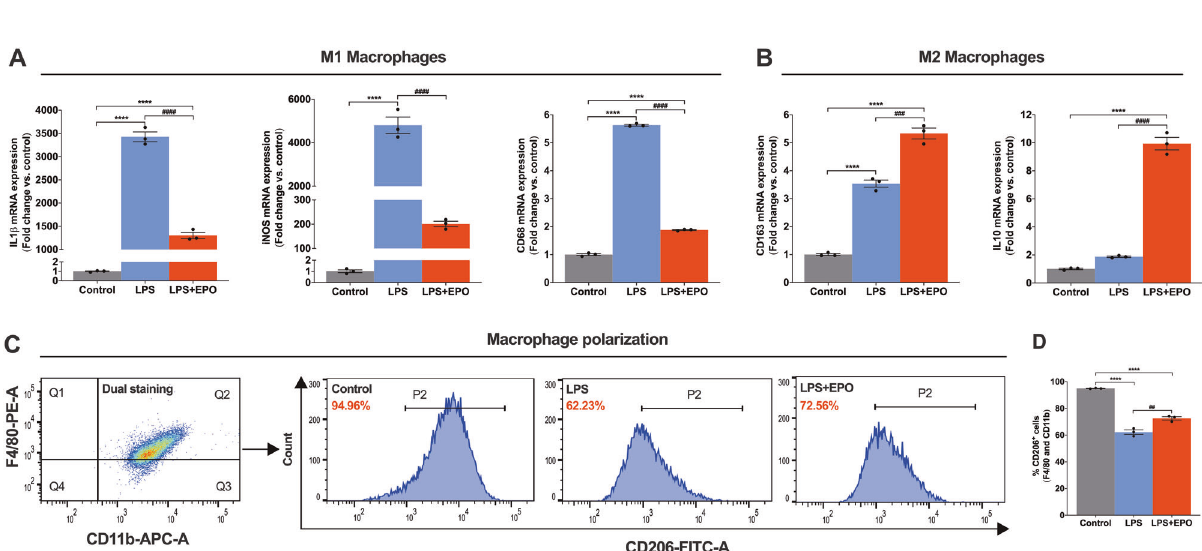
Fig. 5 EPO treatment promotes BMMØs phenotype transition following LPS treatment. qRT-PCR data shows that EPO treatment signi fi cantly attenuates pro-in fl ammatory genes (IL1 β , iNOS, and CD68; M1 macrophage markers) ( A ) and upregulates anti-in fl ammatory genes (IL10 and CD163; M2 macrophage markers) ( B ) following LPS treatment. BMMØs treated with LPS (50 ng/mL) for 24 h and EPO (5 IU/mL) for 72 h. ( C ). Flow cytometry gating strategy of dual staining BMMØs (CD11b + F4/80), where that shows (P2, histograms) LPS + EPO treatment signi fi cantly shifts expression of CD206 + M2 phenotype macrophages as compared to LPS treatment, and the results are represented as a bar graph ( D ). One-way ANOVA, Tukey ’ s multiple comparisons test. Data were expressed as means ± SEM, **** P < 0.0001, Control vs. LPS